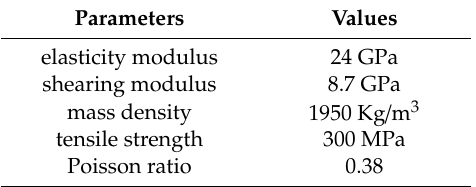
Table 1. Mechanical property parameters of epoxy resin materials.